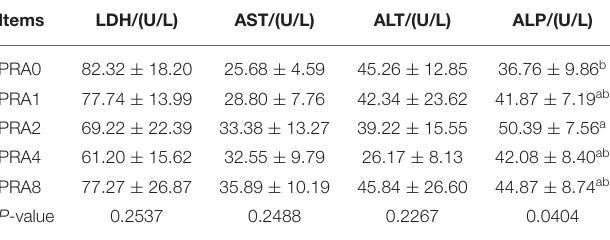
TABLE 5 | Effects of dietary PRA extract levels on serum enzyme index of raccoon dog.